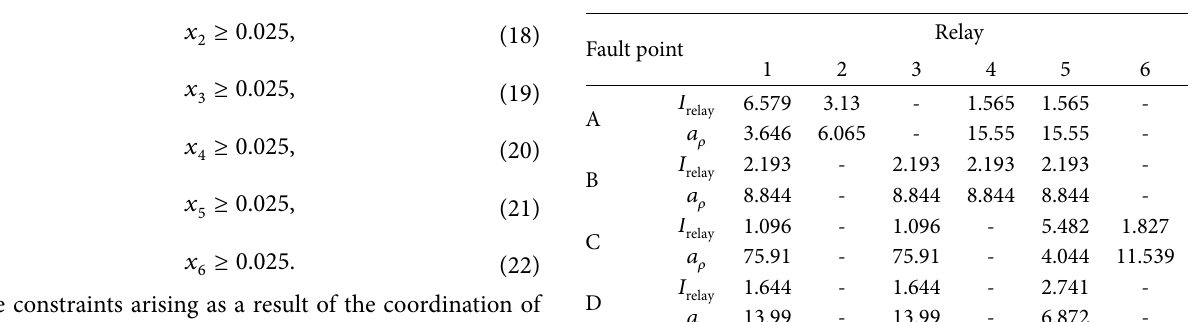
Table 4: 𝑎 Constants and relay currents for Case 𝜌